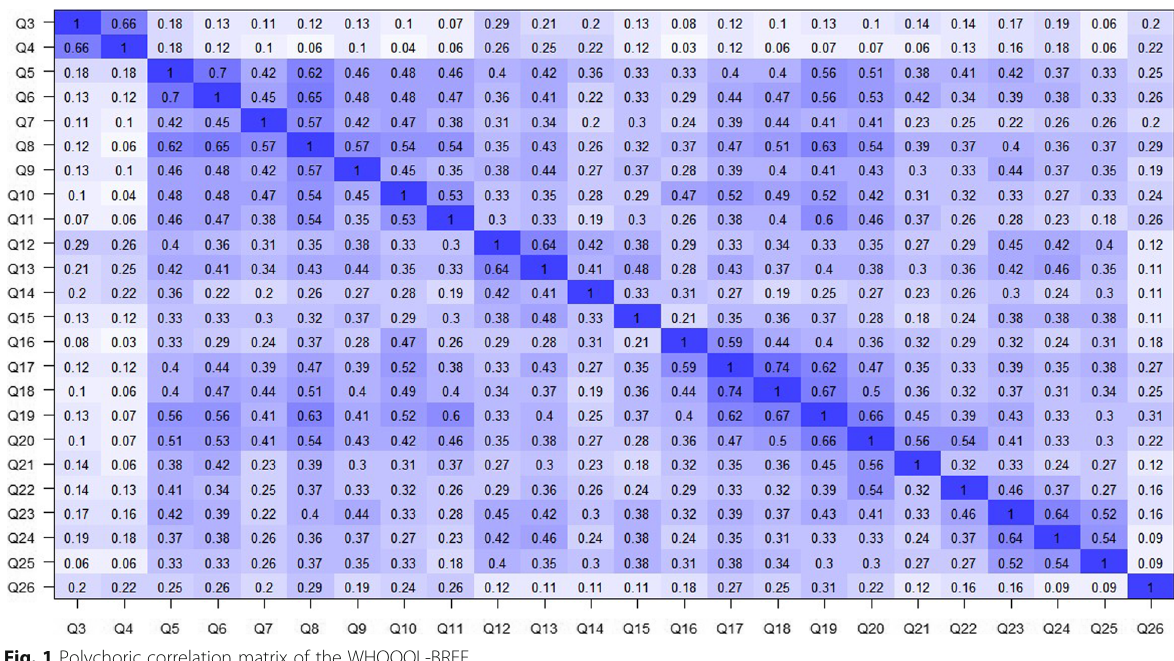
Fig. 1 Polychoric correlation matrix of the